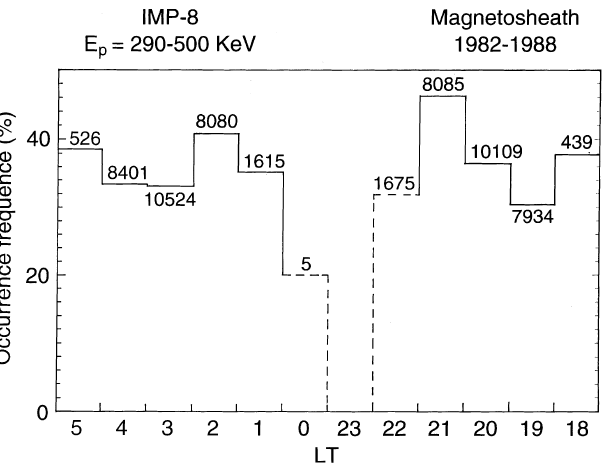
Fig. 3. Occurrence frequency of 290–500 keV/n ions in the magne- tosheath as a function of local time. The highest occurrence frequency was detected near the dusk magnetopause, between 21 LT and 22 LT